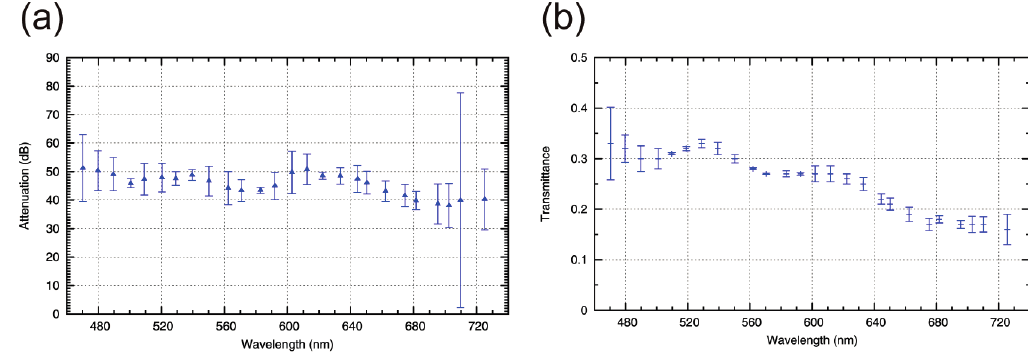
Figure 5. ( a ) Measured attenuation of monochromatic radiation as a function of wavelength. ( b ) System transmittance as a function of